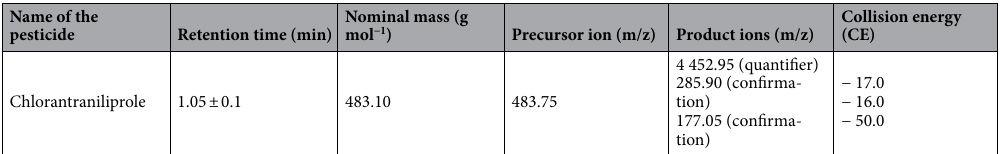
Name of the pesticide